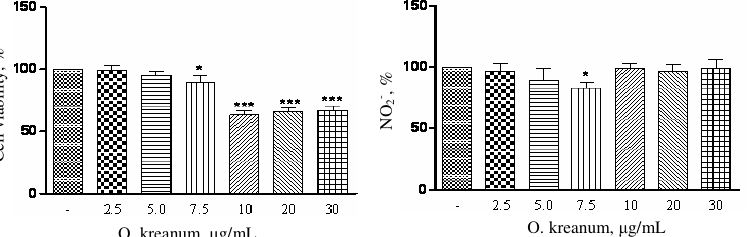
Figure 1. Effect of O. koreanum on cell viability and nitric oxide release in neuro-2a cells. Values are means ± SD of three measurements. * p < 0.05, ** p < 0.01, *** p <